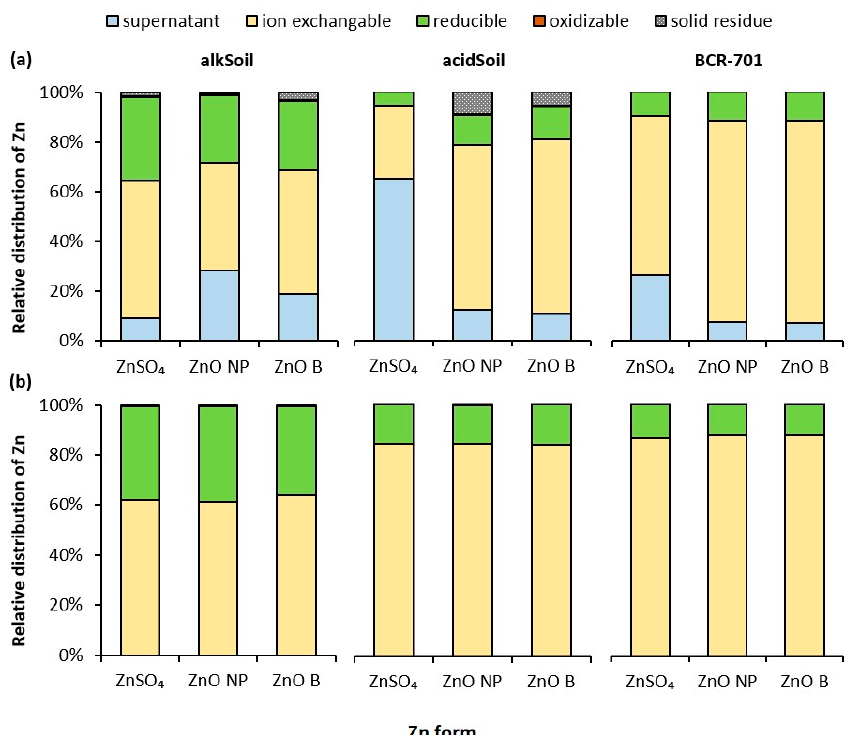
Figure 1. Zn distribution obtained for the contaminated solid materials alkSoil, acidSoil and BCR-701 using the modified BCR sequential extraction procedure. ( a ) presents relative content of Zn contained in all fractions of the experiment and ( b ) only in the three fractions of modified BCR sequential extraction procedure: ion exchangeable, reducible and oxidizable fractions.